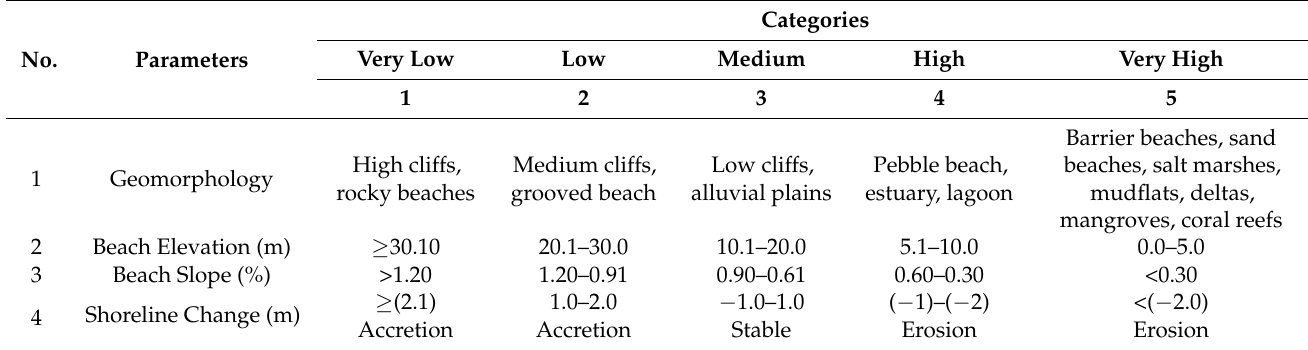
Table 2. Vulnerability parameter classes. (Sources: [29–31]).